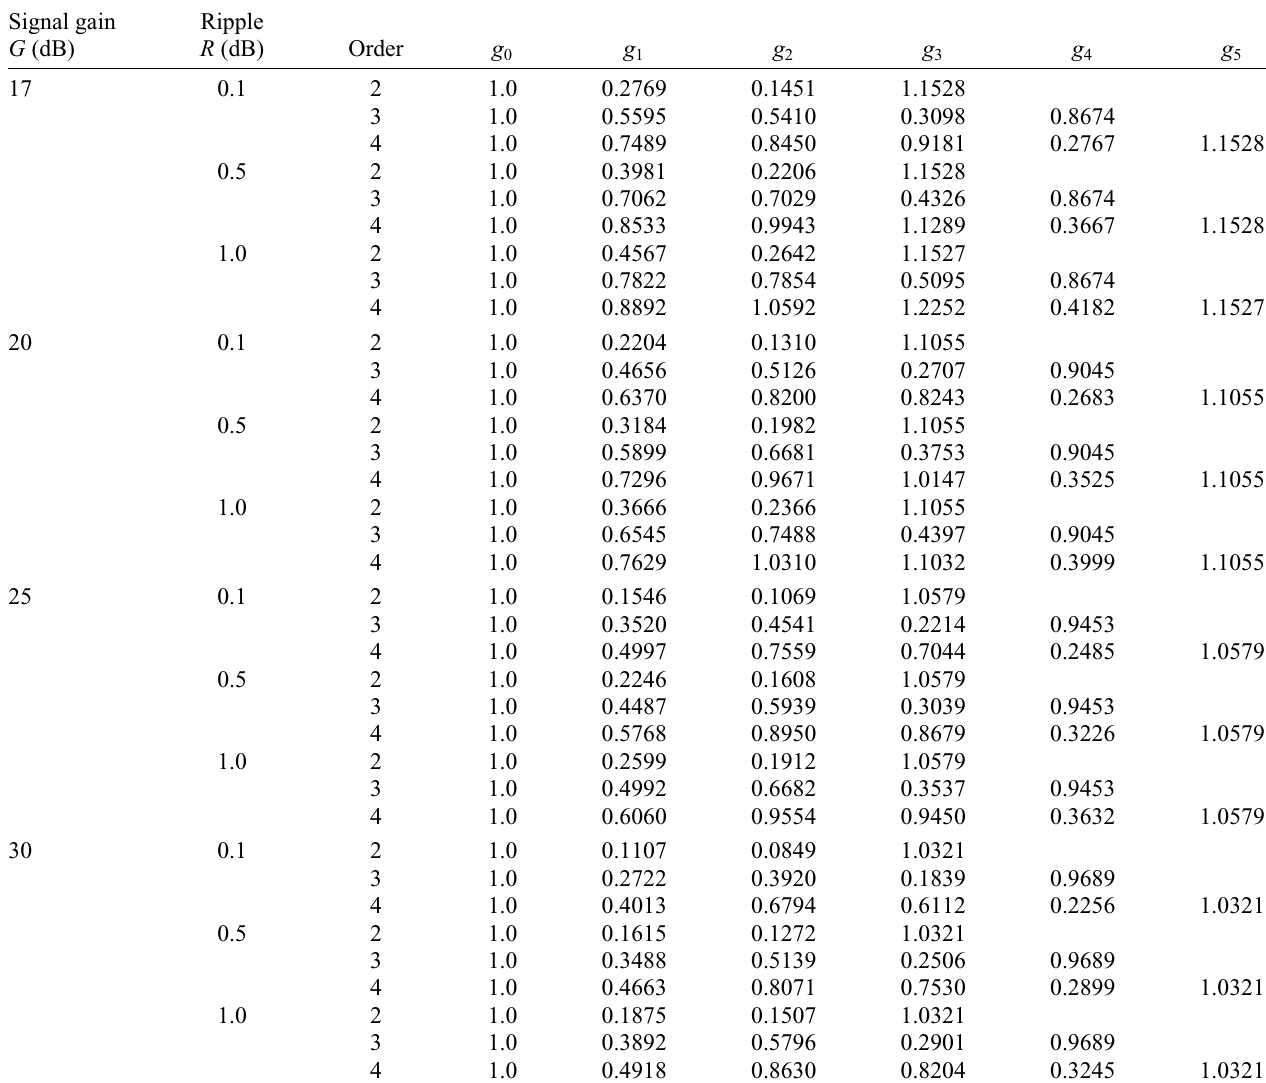
TABLE III. Chebyshev coefficients calculated according to Appendix E for several values of amplifier gain and gain ripple, and for two-, three-, and four-section networks, using the power loss function in Eq. (E12). Coefficient g 0 refers to the active